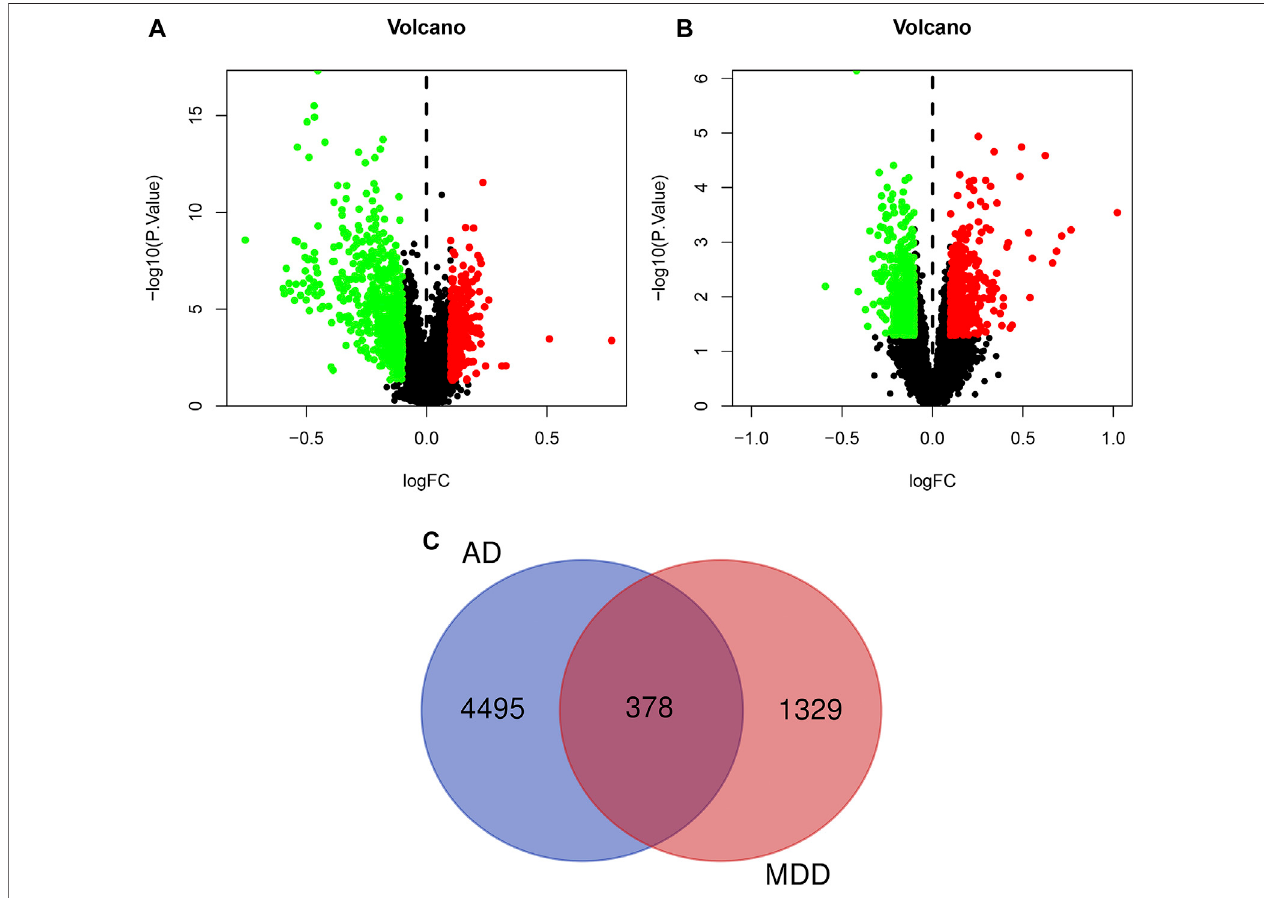
FIGURE 3 | Volcano plot of differentially expressed genes in AD (A) and depression (B) . The red dots represent signi fi cantly up-regulated genes, the green dots represent signi fi cantly down-regulated genes. Panel (C) refers to the overlapped genes of AD and depression.